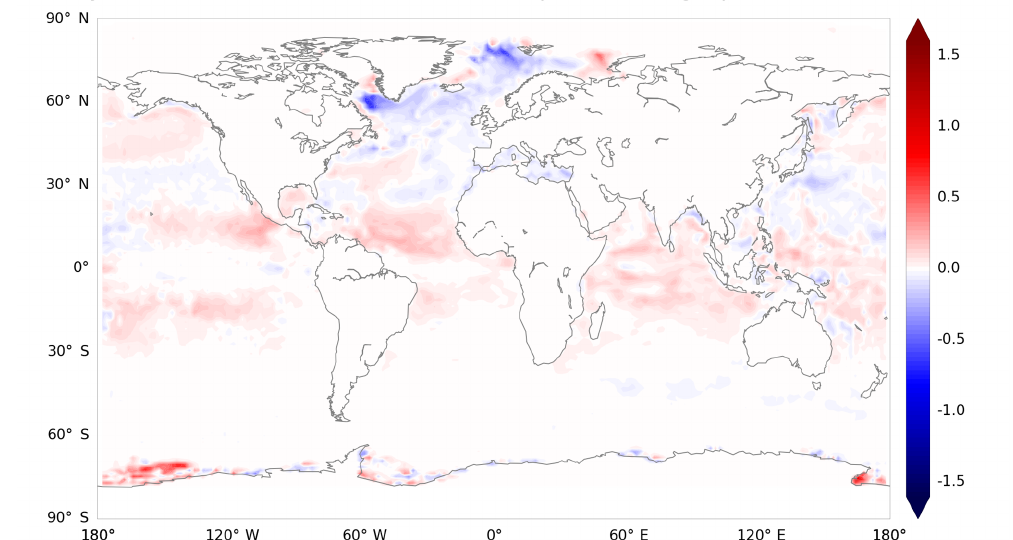
Figure B1. Difference in sea surface temperature monthly mean ( ◦ C) for the first month of simulation between a NEMO 4.0 simulation performed emulating single-precision arithmetic and a NEMO 4.0 simulation performed using double-precision arithmetic. The monthly mean of the sea surface temperature for the first month of simulation shows localized biases exceeding 1.5 ◦